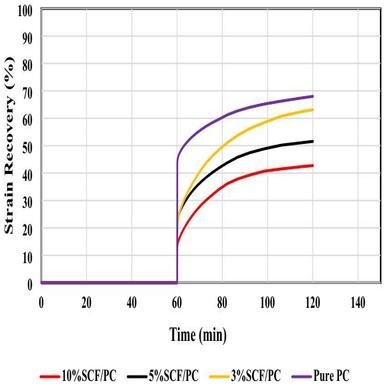
Variation in strain recovery for variable SCF percentage at a different time interval.